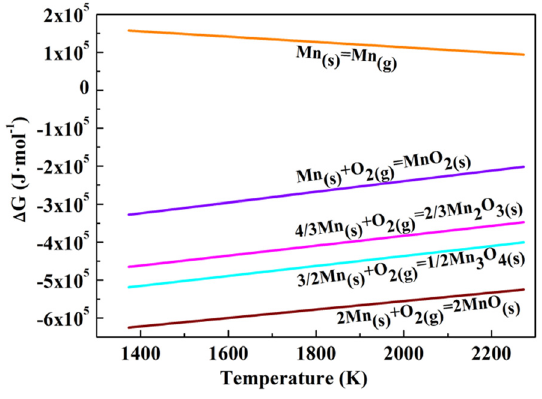
Figure 10: Gibbs free energy of di ff erent manganese oxides at dif - ferent temperatures.